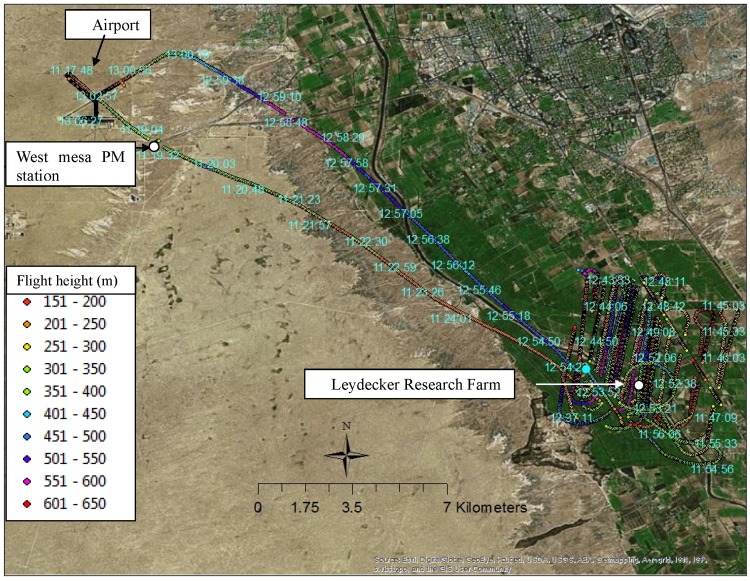
Airplane GPS tracks during the regional PM10 experiment on April 1, 2008, at Mesilla Valley, Las Cruces, NM (colored points: 1-s tracks).The labels are the time of the points.